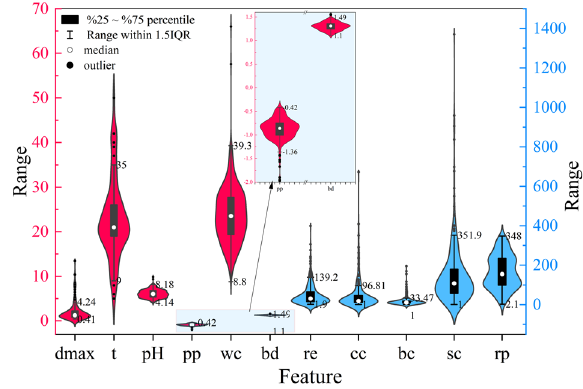
Fig. 1 Data distribution and outliers. A combination of box plot and violin plot to visualize the distribution and outliers of the